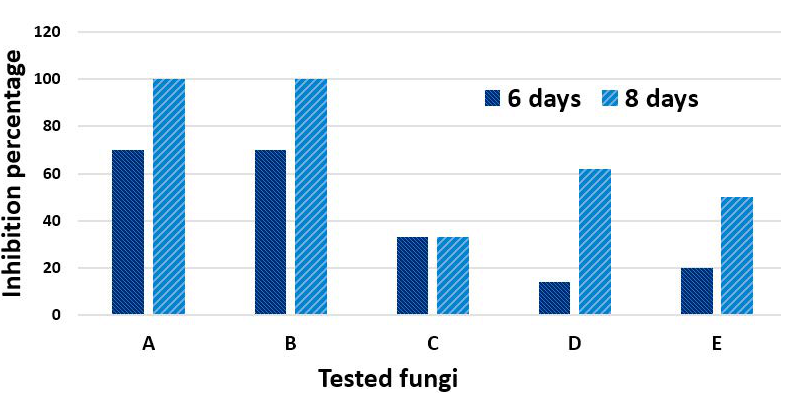
Fig. 9. Inhibition percentage in A ( F. solani ), B ( F. thapsinum ), C ( Penicillium sp . ), D ( T. harzianum ) and E ( Penicillium cyclopium ) grown in PDA after 6 and 8 days of incubation during the antagonism with Marasmius